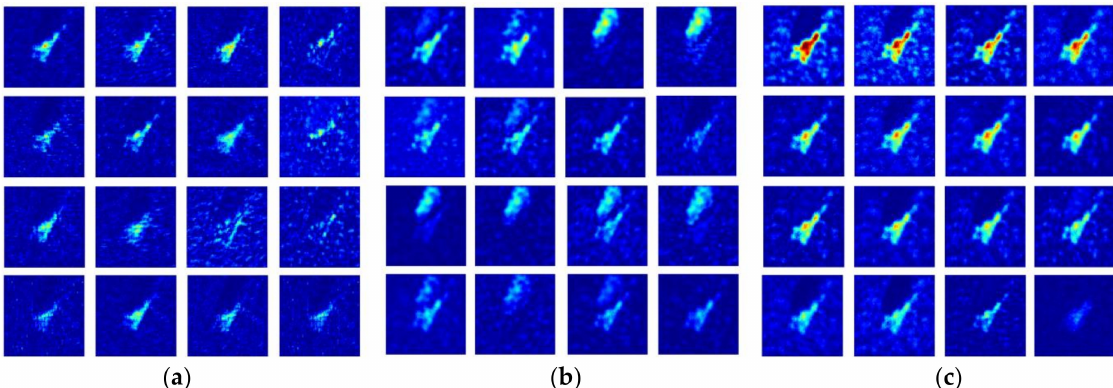
Figure 8. 16 strongest channel-wise activation maps of BMP2 SAR target image. ( a ) Activation maps from the basic CNN; ( b ) activation maps from the SE network; ( c ) activation maps from the DS-AE